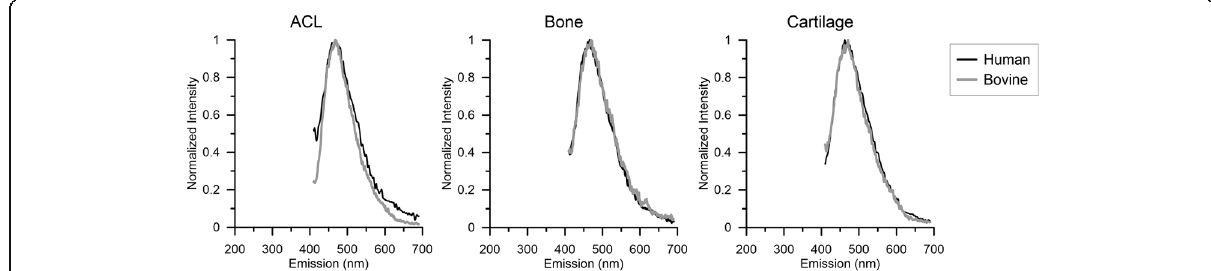
Fig. 2 Emission spectra at 390 nm excitation of bone, ACL, and cartilage for the bovine ( gray ) and human ( black ) samples superimposed to display the resemblance in fluorescent response